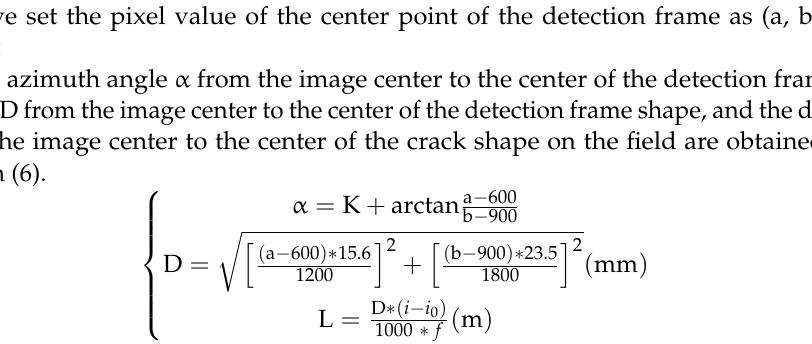
Figure 7. Positioning geometry